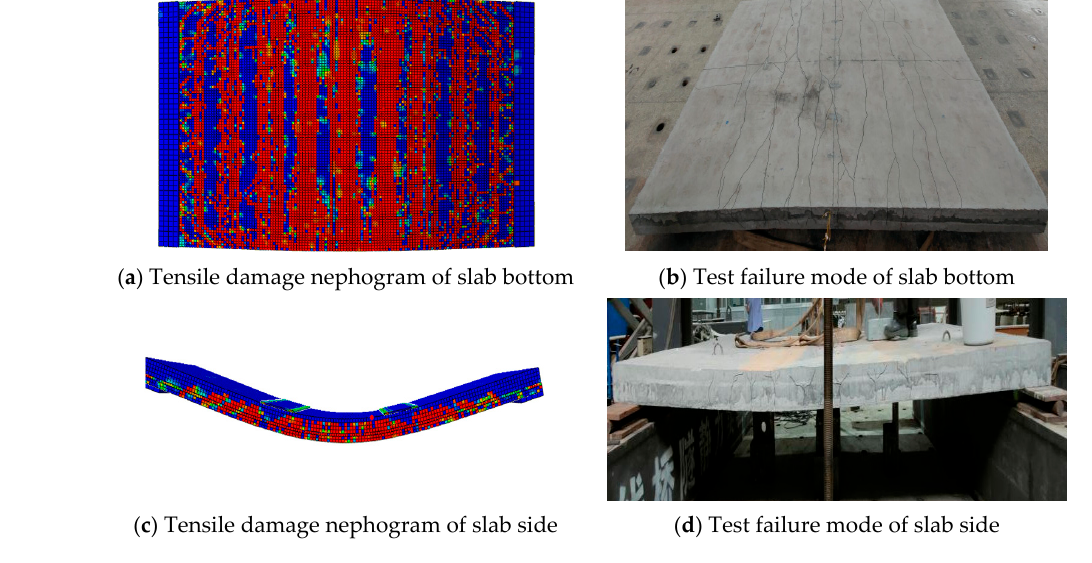
Figure 18. Tensile damage nephogram and failure mode.